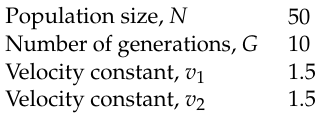
Table 1. Initialized value for selected